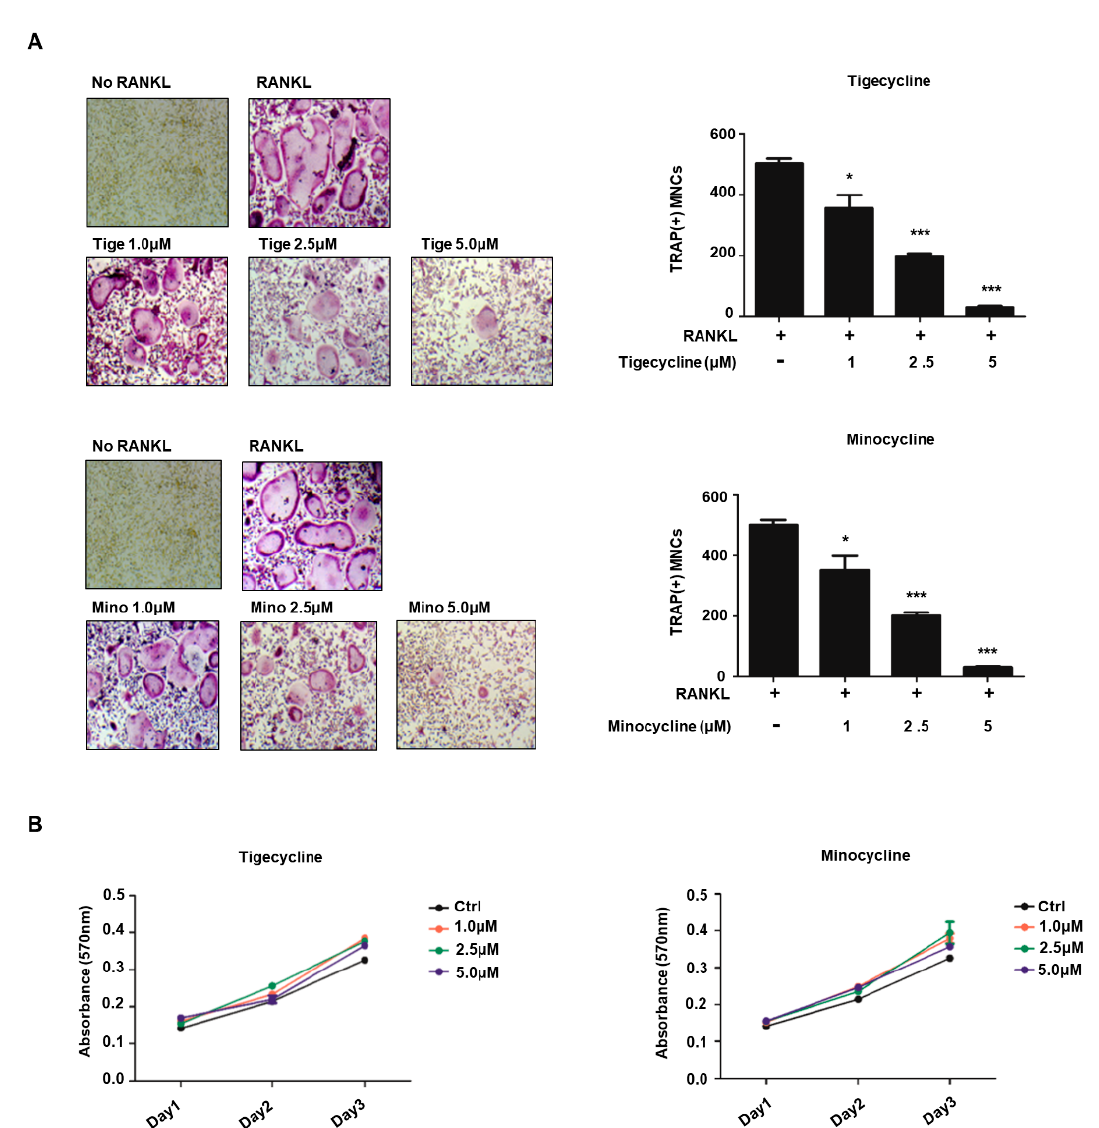
Figure 2. Tigecycline and minocycline suppress osteoclast formation from BMMs. ( A ) BMMs were treated with M-CSF and RANKL in the absence or the presence of increasing concentrations of tigecycline or minocycline for three days, and osteoclast formation was examined by tartrate-resistant acid phosphatase (TRAP) staining (left) and counting the number of TRAP-positive multinuclear osteoclasts (right). ( B ) BMMs were treated with M-CSF in the presence of tigecycline or minocycline, as in ( A ), and cell proliferation was measured by MTT assays. Error bars represent the mean result ± SD of three independent experiments; * p < 0.05, *** p < 0.0001 (ANOVA analysis).